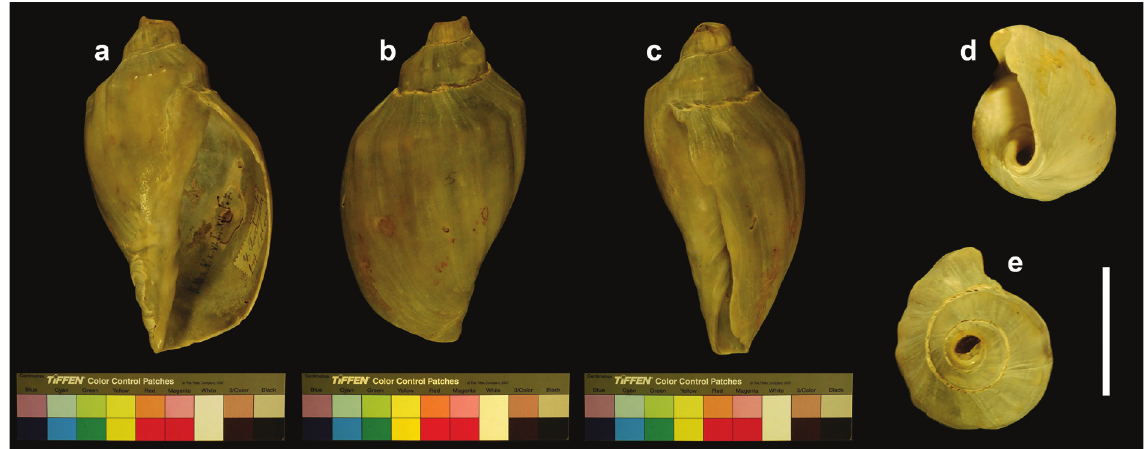
Figure 54. Voluta tuberculata pseudofusiformis , holotype figured by Lahille (1985: pl. XII, fig. 7). a Apertural view b Dorsal view c Lateral view d Umbilical view e Apical view. Scale bar: 5 cm.